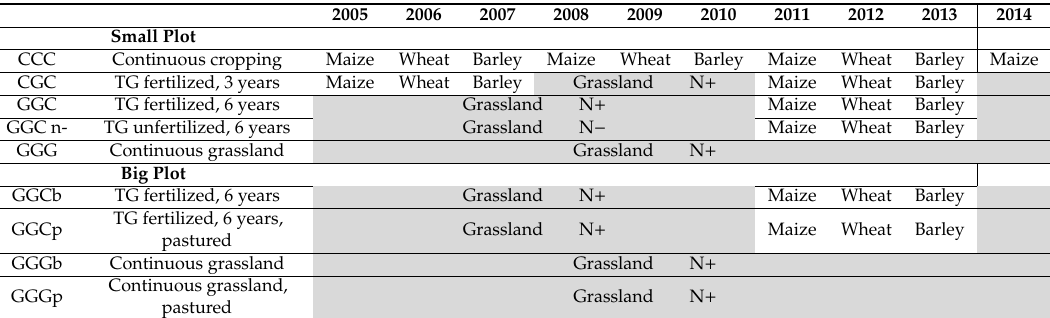
Table 1. Experimental design of SOERE ACBB with the studied treatments. The vertical bold line indicates the date of sampling (March 2014); shaded zones indicate grassland